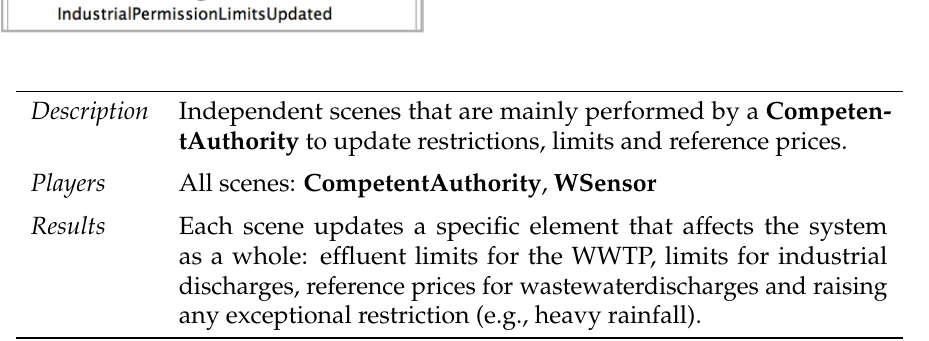
Figure A7. Landmark patterns for CompetentAuthority control policies. These diagrams show the different carried out by the CompetentAuthority : upper-left describes how water quality is assessed and restrictions are enabled to ensure water quality policies. Upper-right show how the effluent limitations for WWTP are determined. Lower-left diagram depicts how industrial permits are calculated according to water policies and current river status. Bottom-right diagram shows how discharge references prices are determined to be used later on in the negotiation process between industries and WWTP s